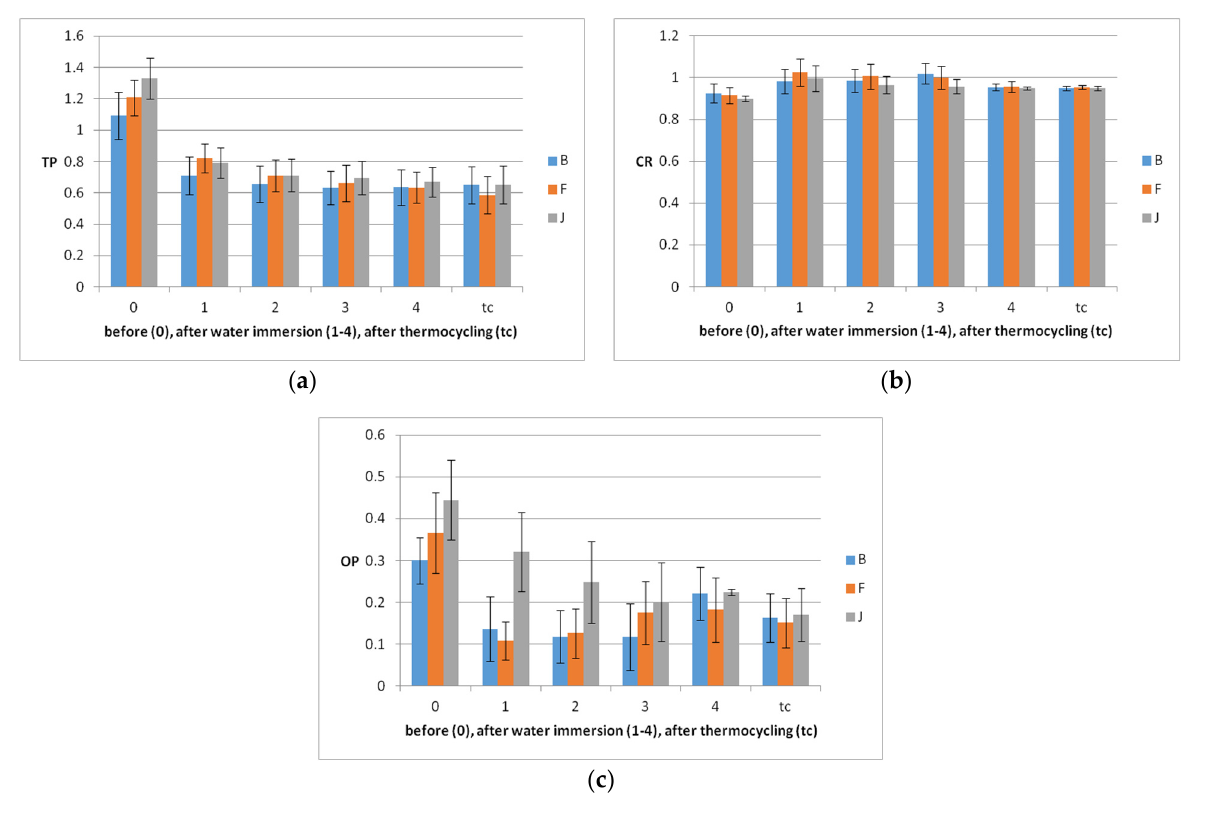
Figure 7. Mean optical parameters values of the samples with SD before each week of water immersion (0), after (1–4), and after thermocycling: ( a ) TP, ( b ) CR, and ( c ) OP.